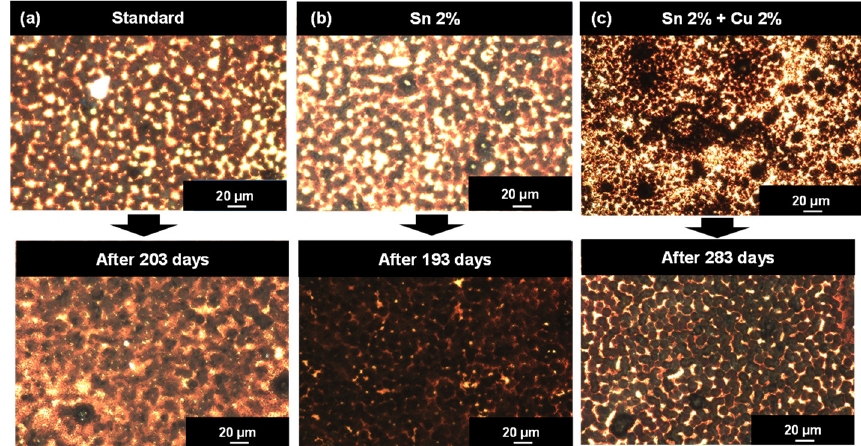
Figure 5. Optical microscope images of the devices.